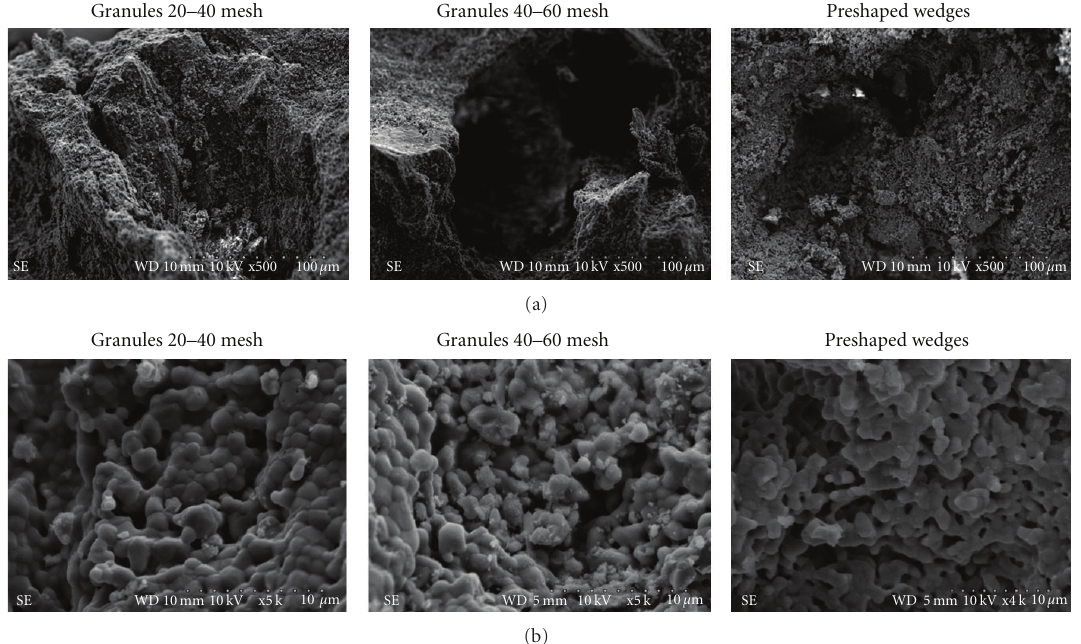
Figure 2: SEM images showing the physical structures of the granules 20–40 mesh, 40–60 mesh and preshaped wedge. The macroporosities (a) and microporosities (b) can be observed in all the